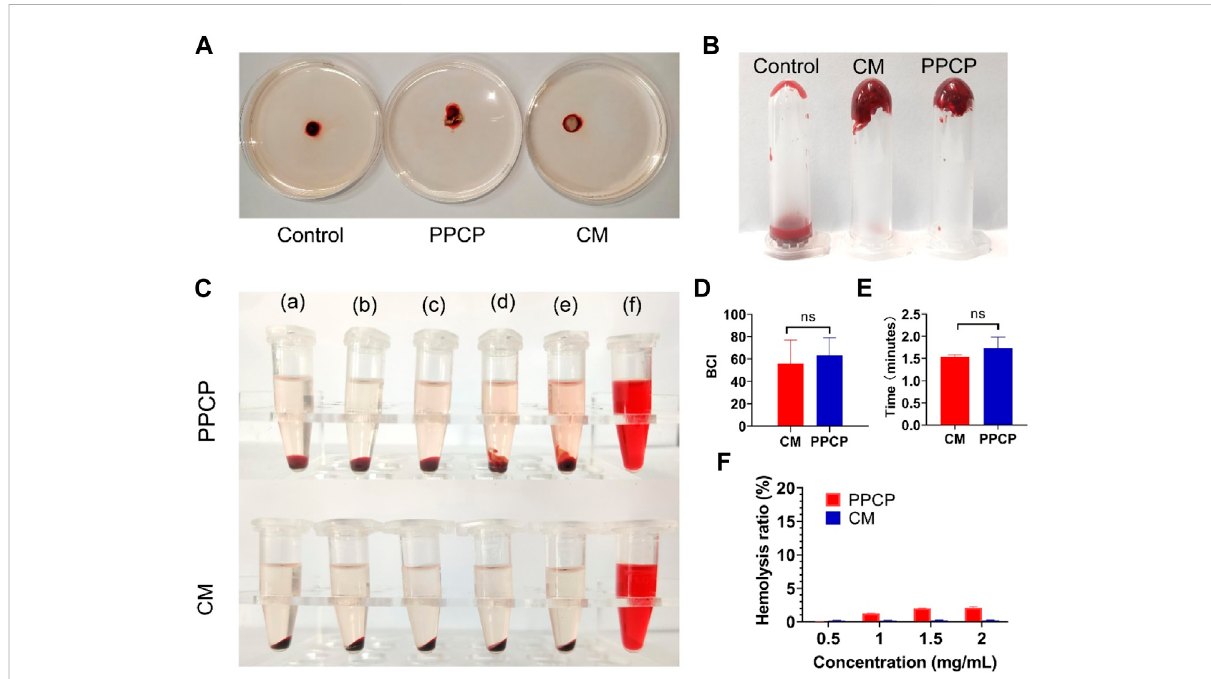
FIGURE 4 Representative graph showing BCI,hemostasis, and hemolysis of 15% PPCP nano fi ber composite membranes and CM. (A) Photographs of BCI; (B) Representative photographs of in vitro hemostasis; (C) Photographs of hemolysis test (a: 0.01 M PBS, b: 0.5 mg/mL PPCP, c: 1 mg/mL PPCP, d: 1.5 mg/mLPPCP,e:2 mg/mLPPCP,f:distilledwater); (D) ThequantitativedataofBCI; (E) Thequantitativedataofhemolysistest; (F) Thequantitative data of in vitro hemostasis test. (Mean ± SD, n =